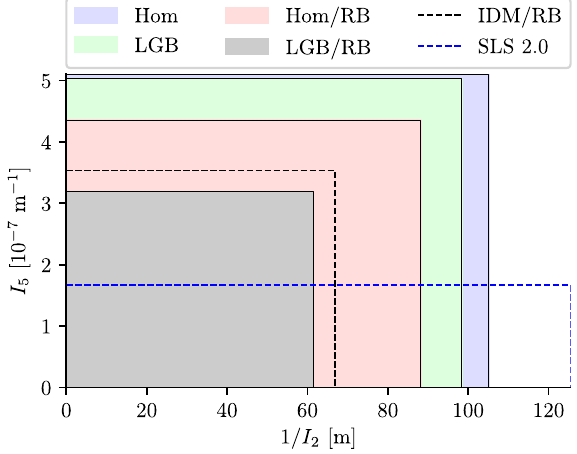
FIG. 18. Comparison of radiation integrals I 5 and I 2 for the example half-cells including SLS 2.0. The area of the respective rectangles is proportional to the emittance when approximating J 1 x ¼